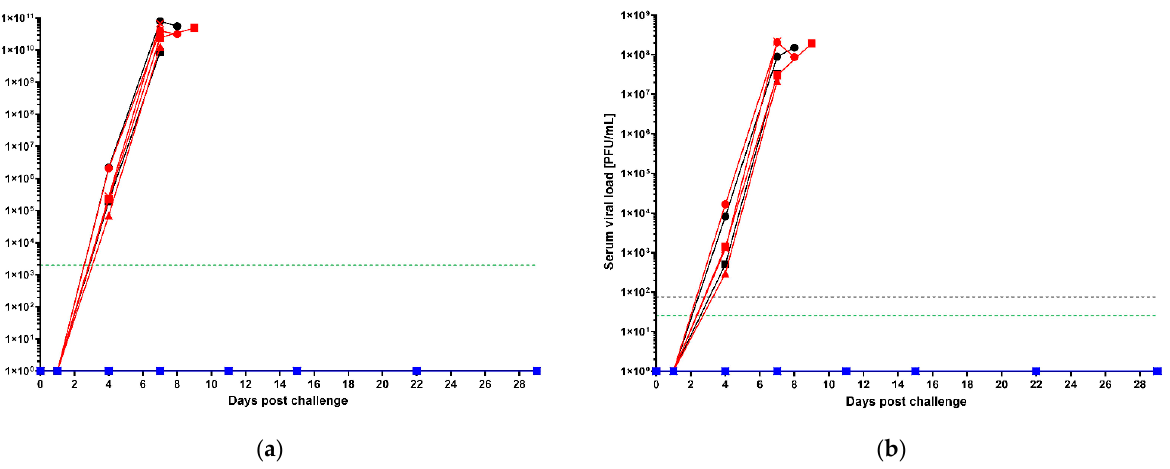
Figure 2. Post-challenge viremia. ( a ) serum viral loads by qRT-PCR; ( b ) serum viral loads by plaque assay. 1 × 10 11 vp animals are shown in blue. 1 × 10 6 vp animals are shown in red. Saline control animals are shown in black. NHP1 of each group is shown as a circle, NHP2 is shown as a square, NHP3 is shown as a triangle and NHP4 is shown as an “ × ”. Lower limit of detection (LOD) is shown as a green dashed line, and the lower limit of quantitation (LLOQ) is shown as a gray dashed line. In cases where the LOD is also the LLOQ, a single green dashed line is shown. The following animals were found dead in cage (FDIC): NHP4, 1 × 10 6 vp (FDIC on day 9 post-challenge; last sample collection was day 7 post-challenge) and NHP2, Saline (FDIC on day 9 post-challenge; last sample collection was day 7 post-challenge). Blood was not collected on the day the animals were FDIC. Two animals that survived to the scheduled end of project were euthanized on day 29, and two others were euthanized on day 32. Data for all four surviving animals are depicted on day